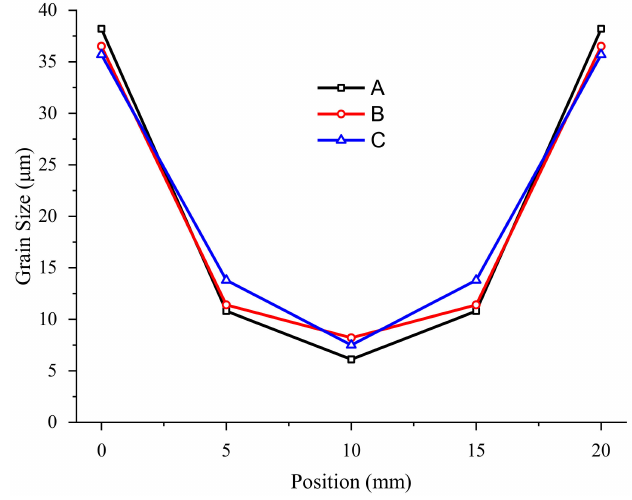
Figure 17. Grain size revolution regularity at specified